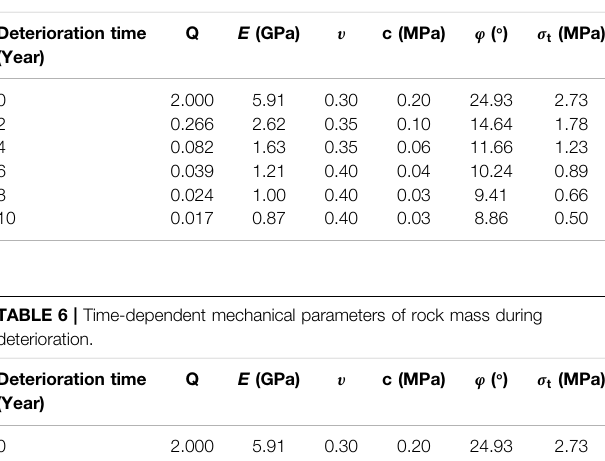
TABLE 7 | Time-dependent mechanical parameters of rock mass during deterioration.